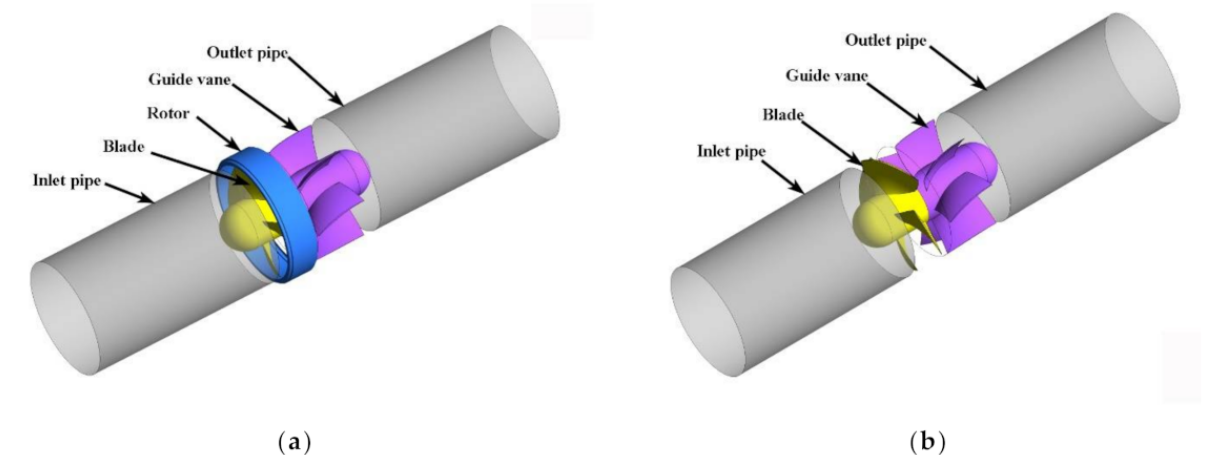
Figure 1. The pump model type: ( a ) the full tubular pump, ( b ) the axial-flow